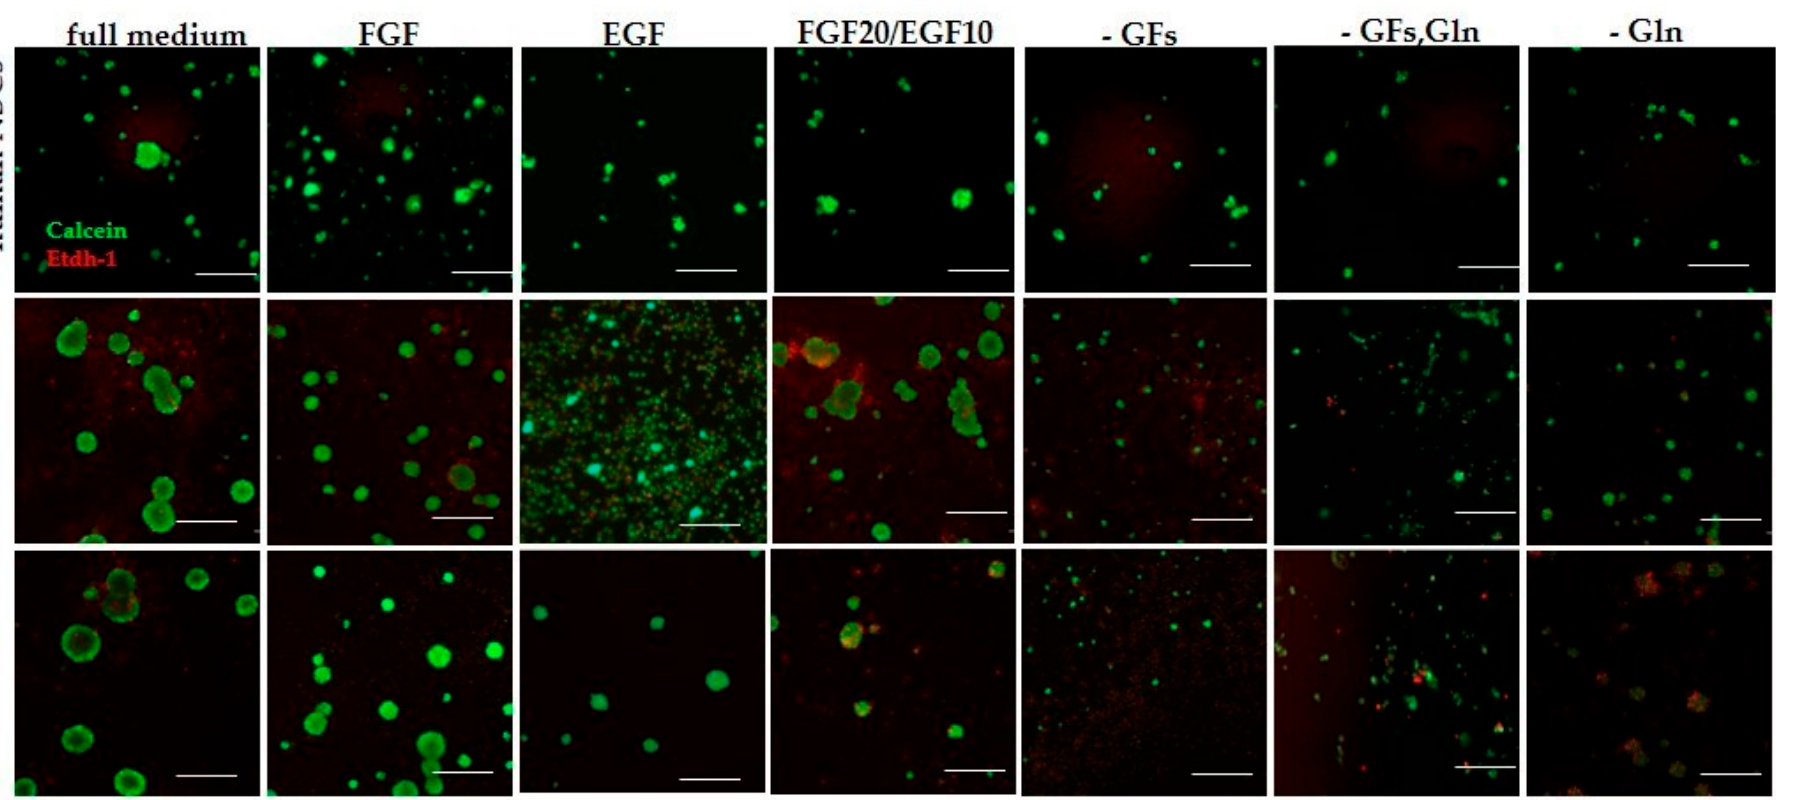
Figure 8. Fluorescence microscopic images of 3D NSCs cultured in different media and spatial conditions, on Day 7 of culture. Cells were stained with calcein (green) and EthD-1 (red) staining. Cell culture conditions: 5% O 2 , 5% CO 2 , 37 °C. Scale: 100 µm.